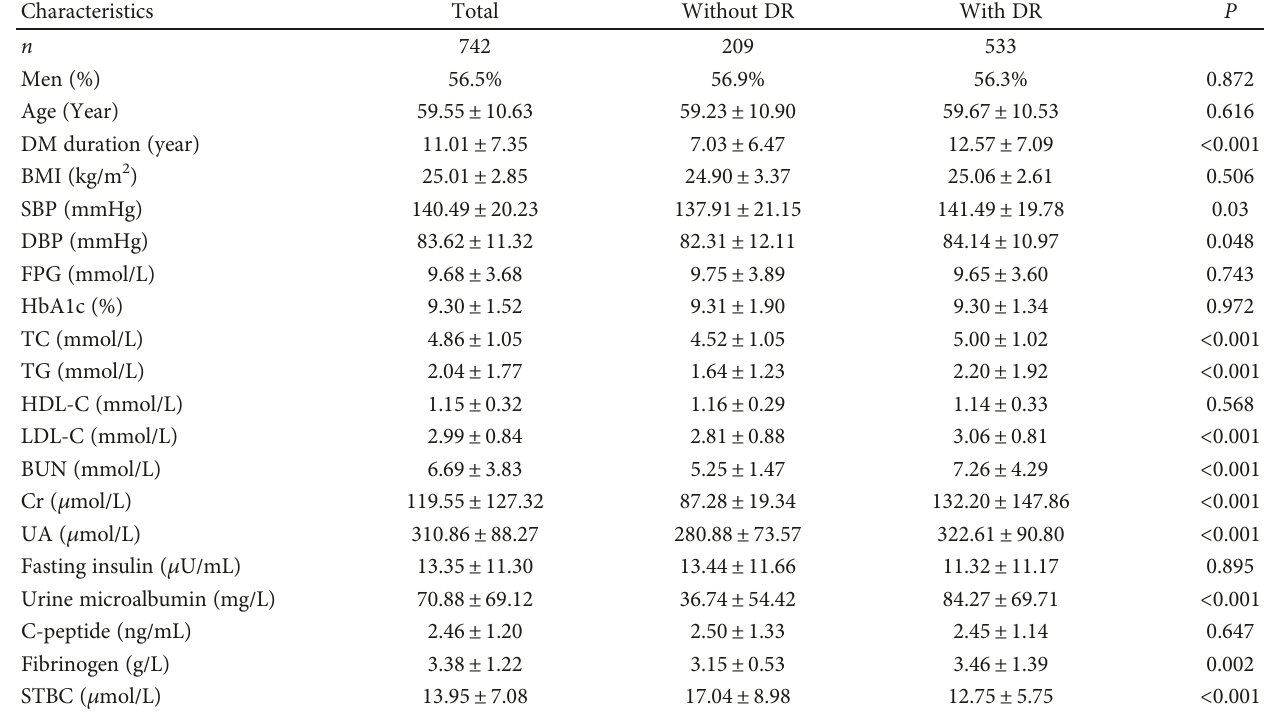
Table 1: Clinical characteristics of the